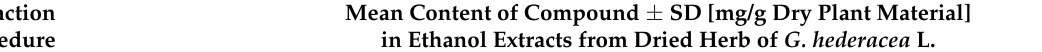
Table 1. Average content of phenolic acids (chlorogenic acid, rosmarinic acid, protocatechuic acid) and flavonoids (rutin and isoquercetin) in ethanol extracts from dried aerial parts of G. hederacea